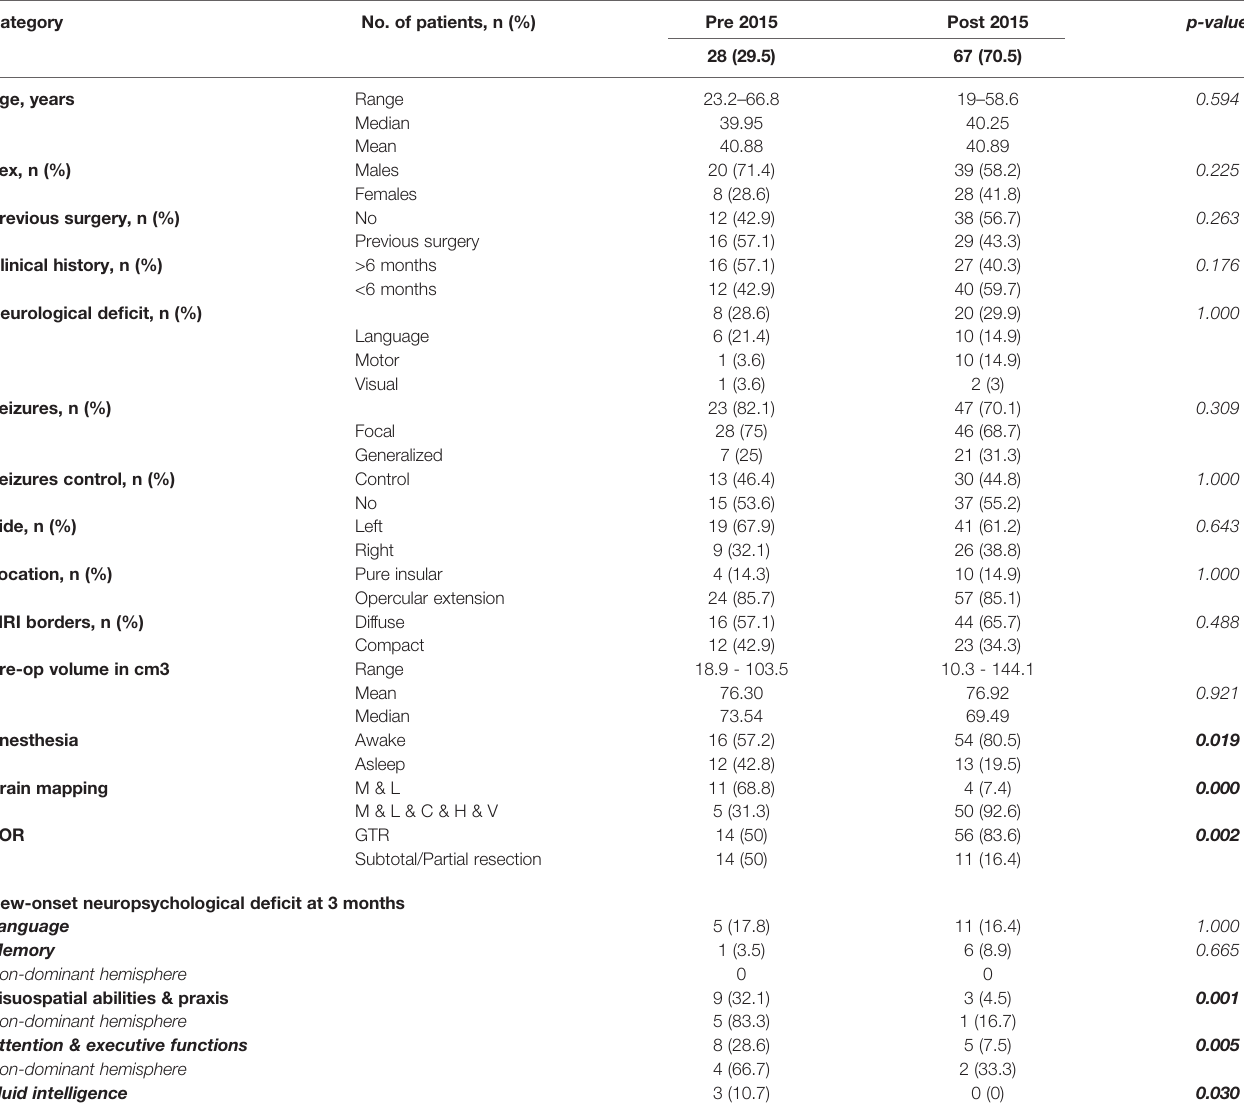
TABLE 4 | Clinical, imaging, surgical, and postoperative neuropsychological features of patients operated before and after 2015.